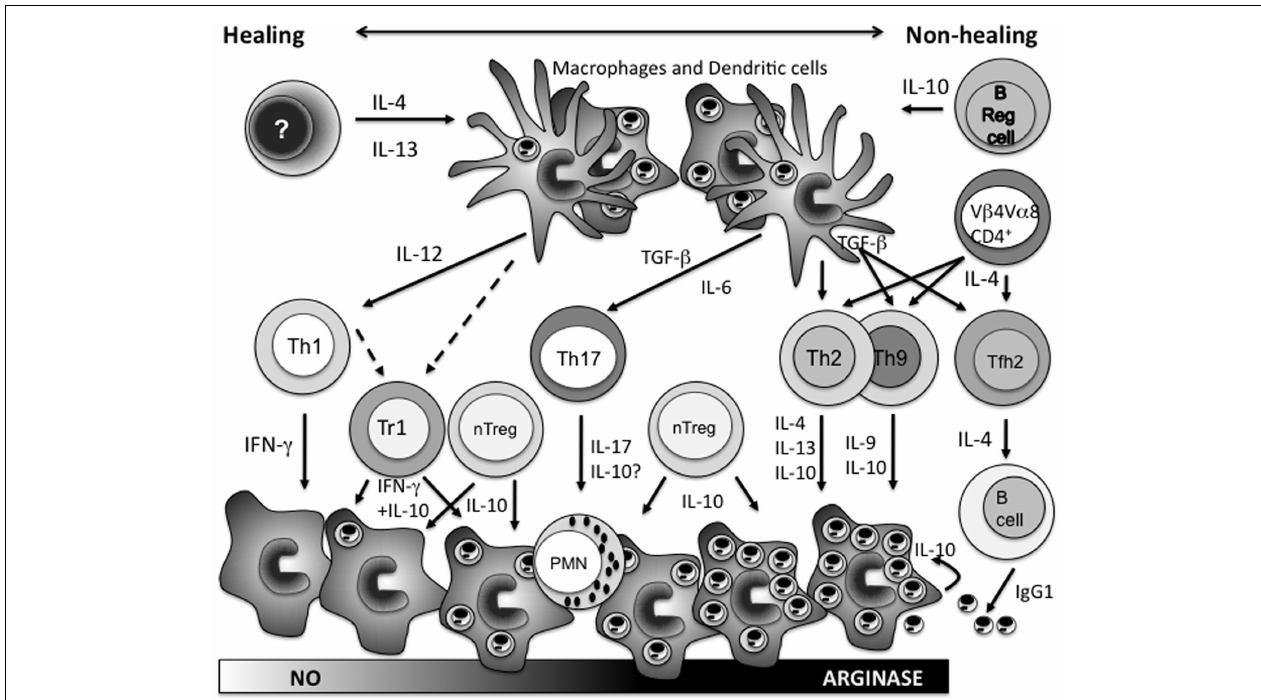
pathology. Expansion ofTh2,Th9, andTfh2 cells is further facilitated under the influence of IL-4 fromV β 4V α 8 CD4 + T cells responding to the parasite LACK antigen.Type-2 cytokines fromTh2/Th9 populations induce alternative macrophage activation, increased arginase expression, and